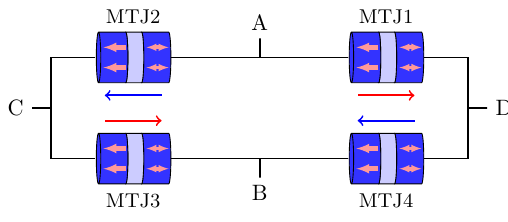
Figure 20. Full bridge